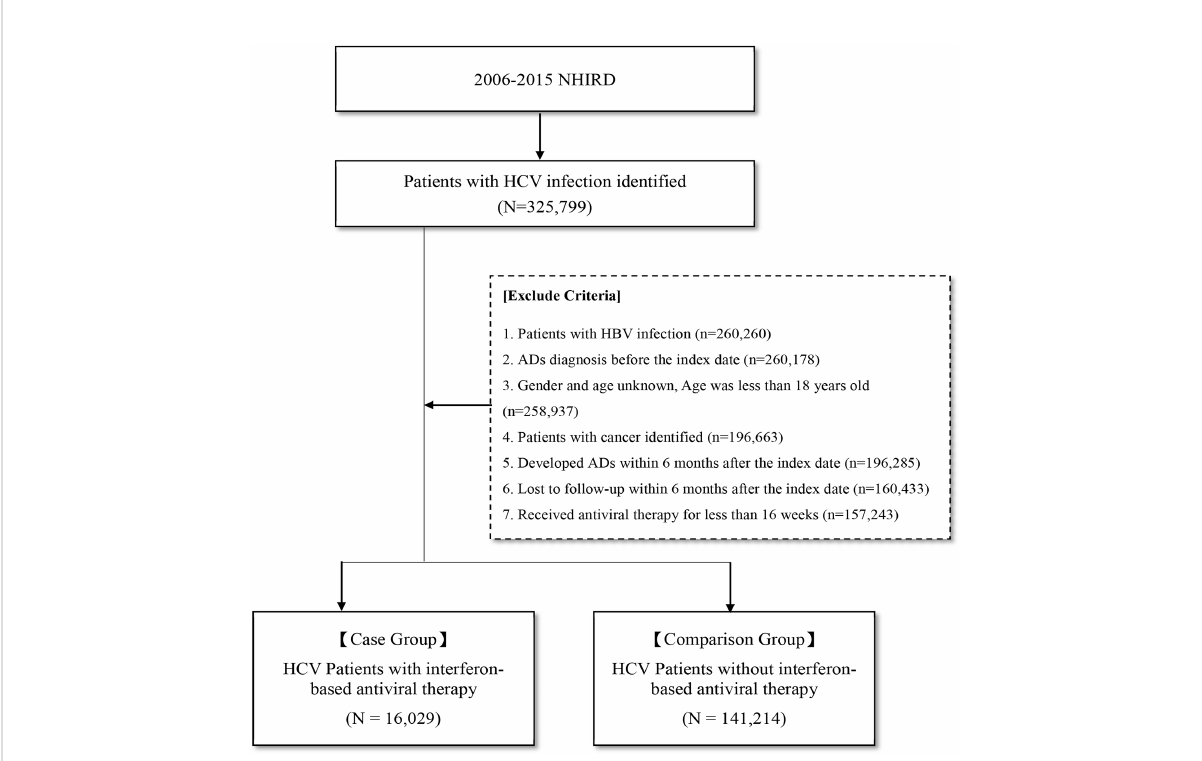
FIGURE 1 Flow Chart for Study Design. AD, autoimmune disease; HCV, hepatitis C virus; NHIRD, National Health Insurance Research